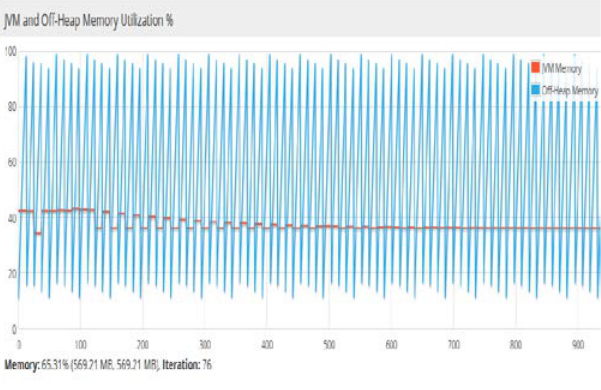
Figure 20. Percentage of the main memory utilization for JVM and heap memory. In DL4j, off-heap memory is the portion of the main memory, which is not used by JVM. Therefore, the work of the garbage collector by JVM is limited. The off-heap memory management was carried out using the underlying native operating system.